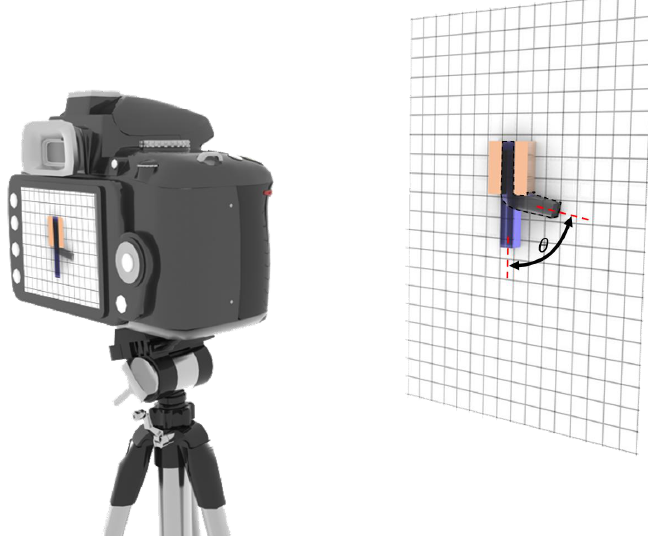
Figure 10. Experimental setup for measuring the actuation performance of the proposed transparent and highly deformable PVC gel-based actuator.